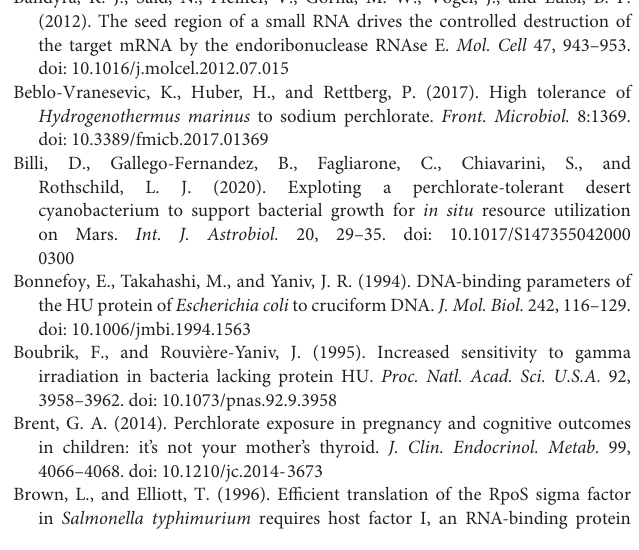
Supplementary Figure 1 | Drop assay in the presence of perchlorate and sodium chloride of E. coli DH10B/pSKII+. Cultures were grown overnight at 37 ◦ C, drops of 10-fold serial dilutions were plated on LB-Ap containing 125 mM of sodium perchlorate or sodium chloride and plates were incubated for 48 h at 37 ◦ C. Supplementary Figure 2 | Survival percentage after UV-B exposure of the individual predicted ORFs involved in perchlorate-resistance and their complete clones. Cultures were grown overnight at 37 ◦ C, drops of 4-fold serial dilutions were plated on LB-Ap agar and plates were incubated for 24 h after exposure to 20 s of UV-B (312 nm) radiation at 2 W m − 2 . Survival percentage was calculated as the number of CFU mL − 1 remaining after the treatment divided by the initial CFU mL − 1 . E. coli DH10B bearing empty pSKII+ (pBlueScript II SK+) vector was used as a negative control. One-way ANOVA followed by Dunnet post hoc analysis revealed the displayed significant differences against the negative control ( ∗ p < 0.05; ∗∗ p < 0.01; ∗∗∗ p < 0.001). Data represent the mean ± S.D ( n ≥ 3). Supplementary Figure 3 | Survival percentage in the presence of 4-NQO of the individual predicted ORFs involved in perchlorate-resistance and their complete clones. Cultures were grown overnight at 37 ◦ C, drops of 4-fold serial dilutions were plated on LB-Ap agar supplemented with 0.2 µ M 4-NQO and plates were incubated for 48 h at 37 ◦ C. Survival percentage was calculated as the number of CFU mL − 1 remaining after the treatment divided by the initial CFU mL − 1 . E. coli DH10B bearing empty pSKII+ (pBlueScript II SK+) vector was used as a negative control. One-way ANOVA followed by Dunnet post hoc analysis revealed the displayed significant differences against the negative control ( ∗ p < 0.05; ∗∗ p < 0.01; ∗∗∗ p < 0.001). Data represent the mean ± S.D ( n ≥ 3). Supplementary Figure 4 | Survival percentage in the presence of hydrogen peroxide of the individual predicted ORFs involved in perchlorate-resistance and their complete clones. Cultures were grown overnight at 37 ◦ C, drops of 2-fold serial dilutions were plated on LB-Ap agar supplemented with 1 mM H 2 O 2 and plates were incubated for 24 h at 37 ◦ C. Survival percentage was calculated as the number of CFU mL − 1 remaining after the treatment divided by the initial CFU mL − 1 . E. coli DH10B bearing empty pSKII+ (pBlueScript II SK+) vector was used as a negative control. One-way ANOVA followed by Dunnet post hoc analysis revealed the displayed significant differences against the negative control ( ∗ p < 0.05; ∗∗ p < 0.01; ∗∗∗ p < 0.001). Data represent the mean ± S.D ( n ≥